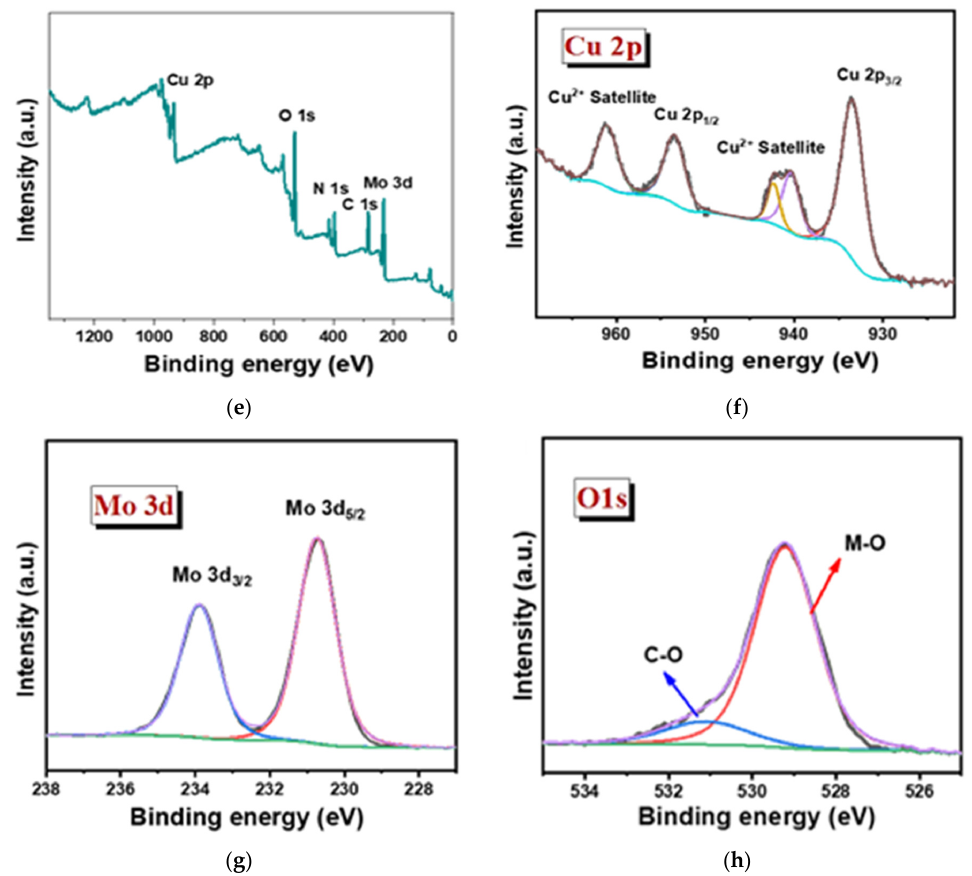
Figure 5. ( a ) Survey spectra of Cu 3 Mo 2 O 9 @DNA; ( b – d ) high magni fi ed XPS spectra of the individual elements Cu 2p, Mo 3d, and O 1s of Cu 3 Mo 2 O 9 @DNA; ( e ) survey spectra of Cu 3 Mo 2 O 9 @CTAB; ( f – h ) highly magni fi ed XPS spectra of the individual elements Cu 2p, Mo 3d, and O 1s of Cu 3 Mo 2 O 9 @CTAB.